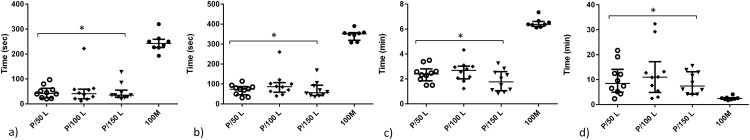
Anaesthetic parameters of adult zebrafish treated with propofol combined with lidocaine or treated with MS222.a) equilibrium loss, b) loss of touch reaction, c) loss of reaction to a painful stimulus, and d) equilibrium recovery of adult zebrafish after being placed in an anaesthetic bath of 2.5 μg/ml of propofol combined with 50, 100 or 150 μg/ml of lidocaine (P/L; n = 10), and of 100 mg/L of MS222 (100M; n = 8). Each point represents an animal. Data are expressed as median [interquartile range]. * p≤ 0.016 compared with 100 mg/L of MS222.